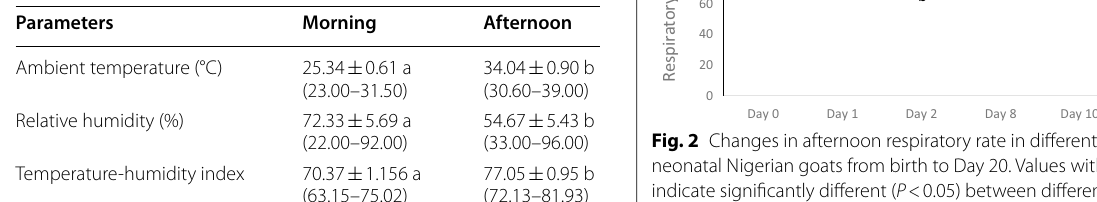
Table 1 Mean ( SEM) values of meteorological parameters in ± the study area